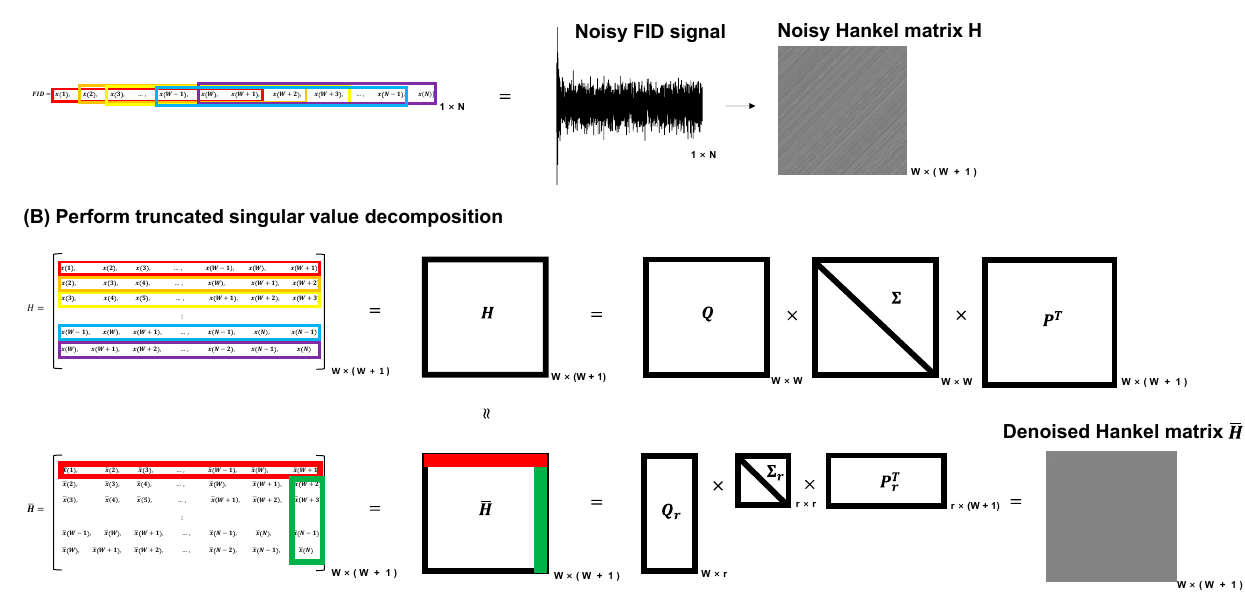
by concatenating first row (red) and last column (green)